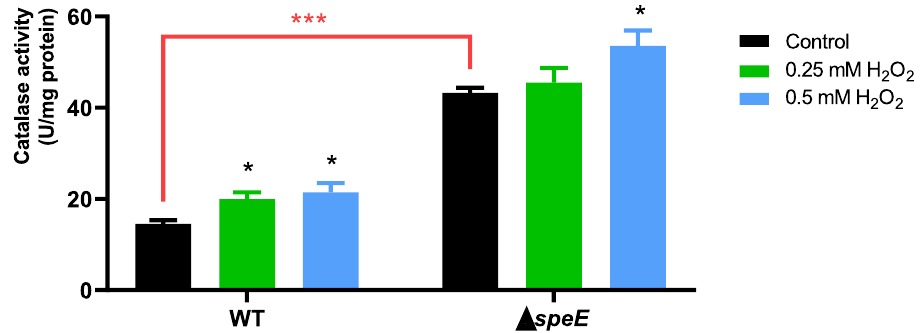
Figure 8. Catalase activity in Pst DC3000 in response to H 2 O 2 . Cells from the wild type and ∆ speE mutant strain grown in M9 were exposed to different concentrations of H 2 O 2 for 1 h. Catalase activity was determined in cell extracts through the decomposition of H 2 O 2 by following the decrease in absorbance at 240 nm. Data from each strain growing under oxidative conditions were compared to their respective control (without H 2 O 2 - amendment) using the Student’s t test. Additionally, controls from different strains were compared (red square bracket). *p < 0.05, ***p < 0.001.